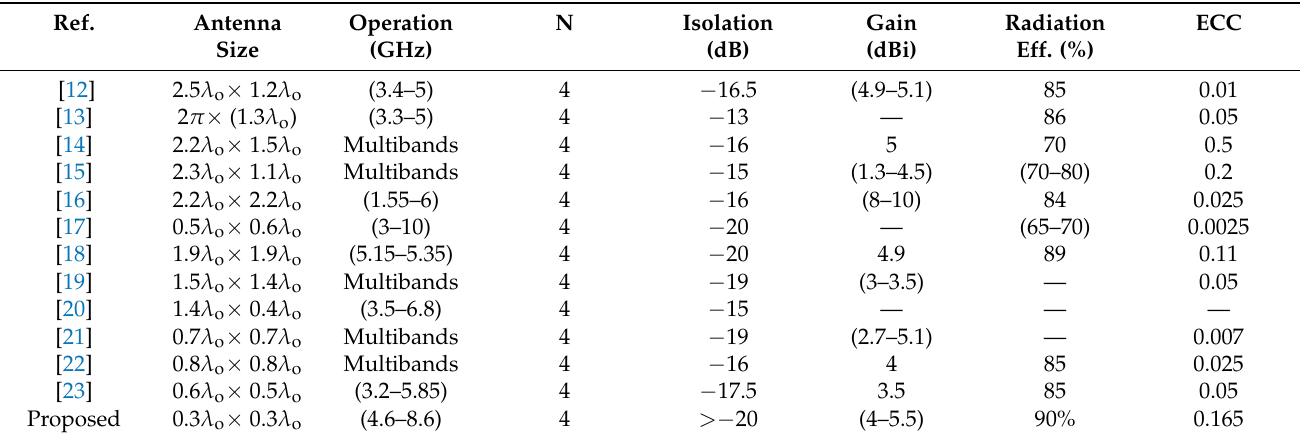
Table 1. The performance comparison of the four-element antenna configuration over the reported antenna designs in [12–23] .